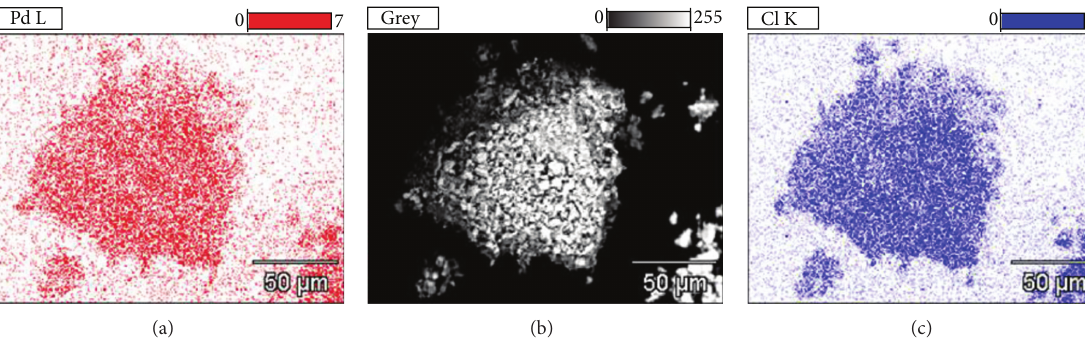
Figure 4: Images of characteristic X-ray emitted by Pd and Cl elements in the Pd/LDH